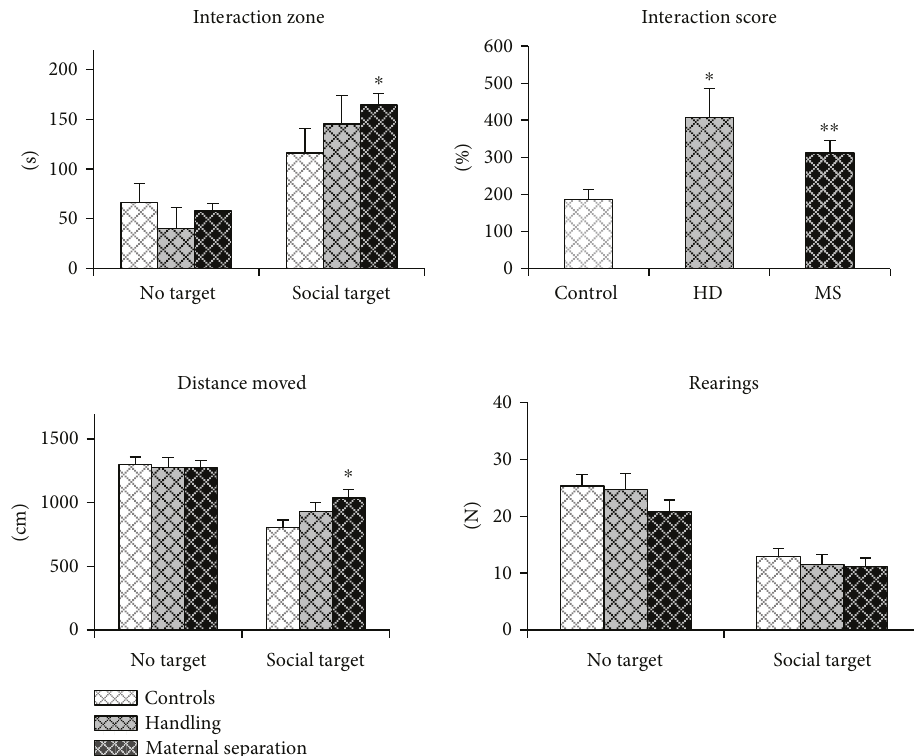
Figure 7: E ff ects of early-life stress on the social behavior of adult female mice. Both stressed females groups increased sociability in the test. Data present as mean ± standard error of the mean (SEM). White box: controls (females n = 11 ); grey box: HD (females n = 6 ), black box: MS (females n = 8 ); no target: the adaptation trial with an empty target box; social target: the interaction trial with an unfamiliar partner in the target box. ∗ p < 0 05 , ∗∗ p < 0 01 compared to controls.